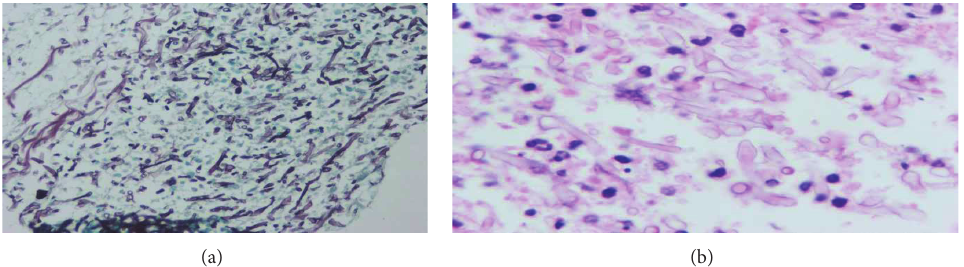
Figure 2: (a) Grocott’s methenamine silver stained histopathological specimen of necrotic cutaneous tissue demonstrating aseptate hyphae ( × 40). (b) Hematoxylin and eosin (H&E) stained histopathological specimen of necrotic cutaneous tissue demonstrating aseptate hyphae ( ×